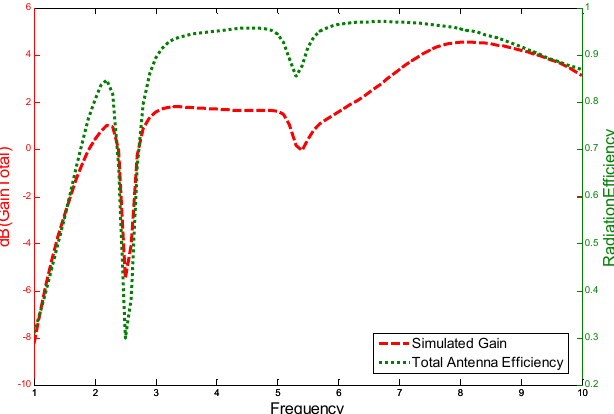
Figure 16. Simulated gain and total antenna efficiency of the proposed antenna.